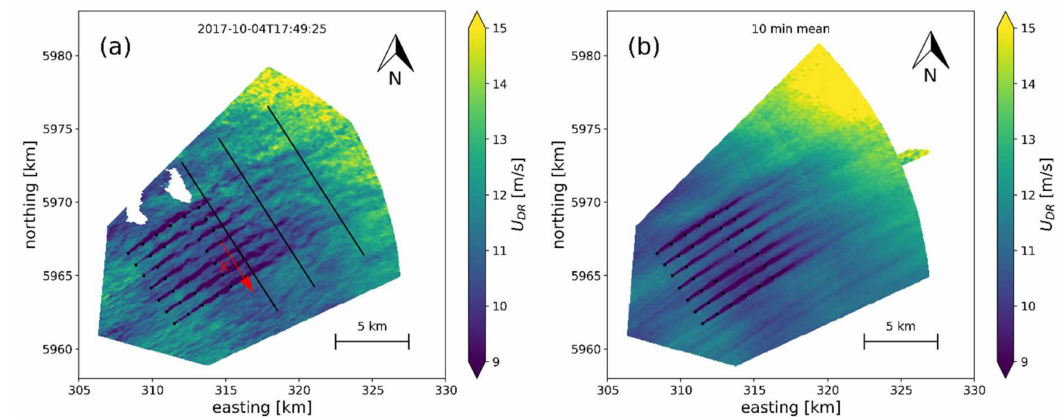
Figure 6. Horizontal wind speed at 100 m from BEACon Doppler radar. ( a ) Instantaneous wind speeds closest to the SAR image in Figure 3 including three at transects 700 m, 3700 m, and 7700 m. ( b ) ten-minute averaged wind speed around the SAR image acquisition